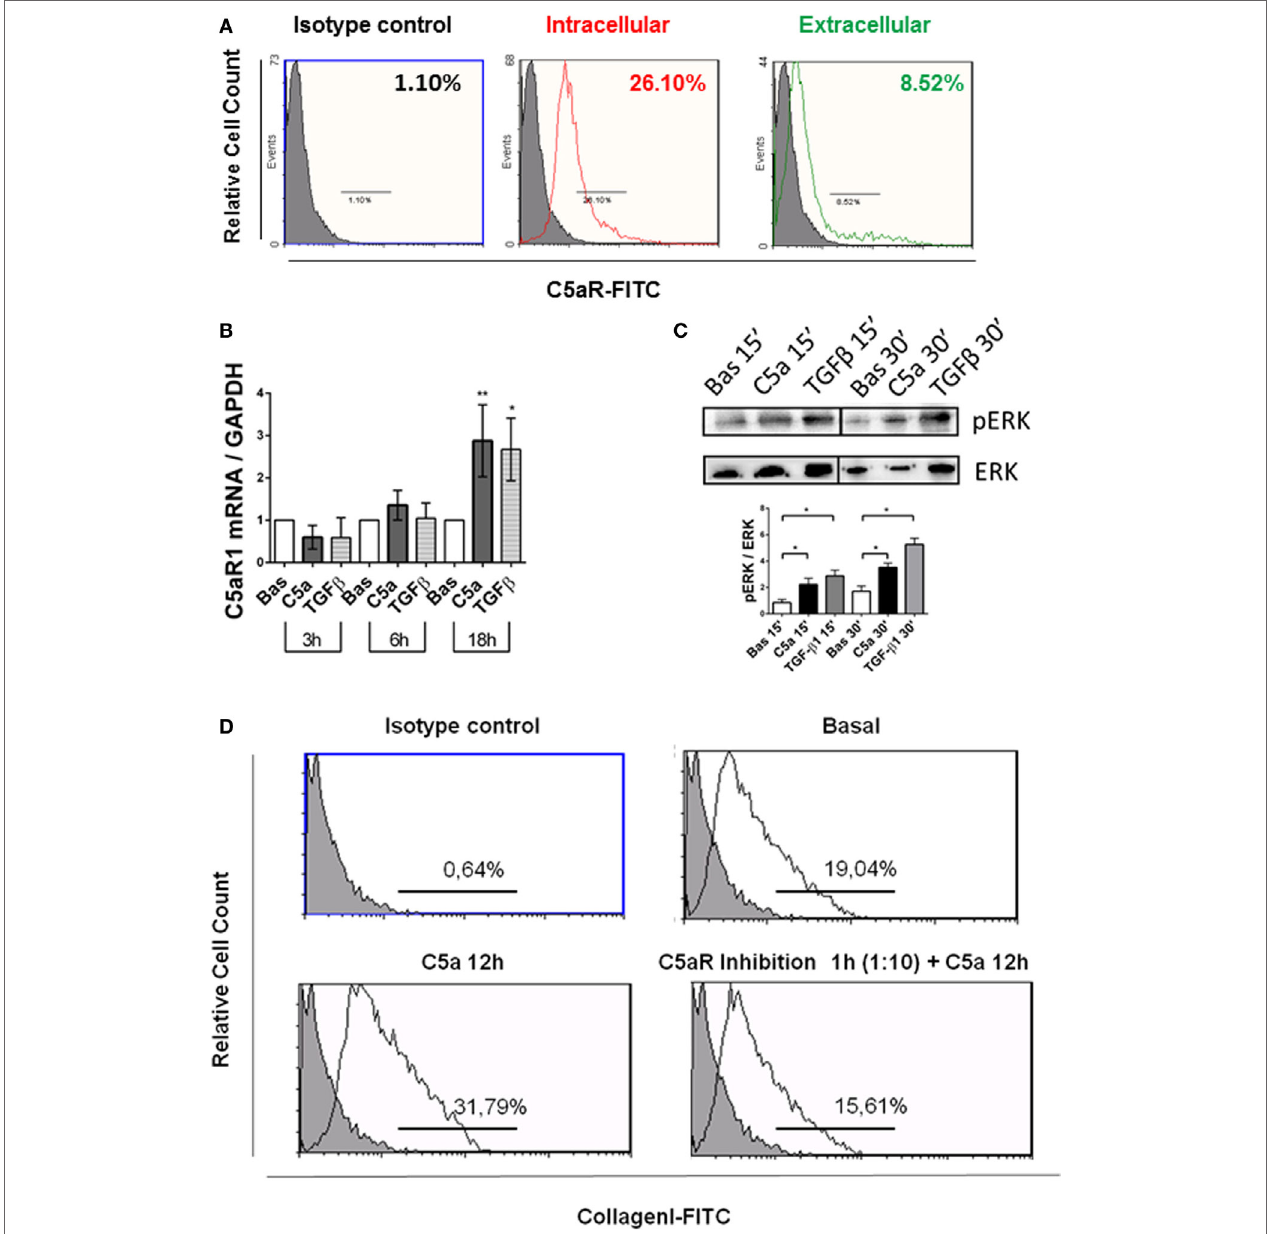
FigUre 8 | C5aR pathway activation contributes to PMT in human pericytes by extracellular signal-regulated kinases (ERK) phosphorylation. (a) Human pericytes expressed C5aR. Pericytes were assessed for presence of C5aR. FACS analysis showed both intracellular and extracellular C5aR expression in permeabilized (intracellular) and not permeabilized pericytes (extracellular) in basal condition. n = 3, MFI, mean fluorescence intensity. (b) qPCR analysis showed an increased expression of C5aR1 gene transcripts in pericytes after 18 h of C5a incubation. Expression levels were normalized by GAPDH. The histograms represent the mean ± SD, n = 3 (** p < 0.01, * p < 0.05, unpaired t -test versus basal for each time point). (c) Western blot of pericytes stimulated by C5a and TGF β for 15 and 30 min. C5a increased the phosphorylation of ERK. Expression levels of pERK were normalized by total ERK ( n = 3, * p < 0.05 versus basal). (D) FACS analysis of pericytes after C5aR blocking showing reduced collagen I production ( in bottom right ). Anti-C5aR (mouse monoclonal) was used to inhibit the binding of C5a to C5aR, before the C5a exposition. Basal (in top, right ), C5a 12 h (in bottom left ) n = 3, p <